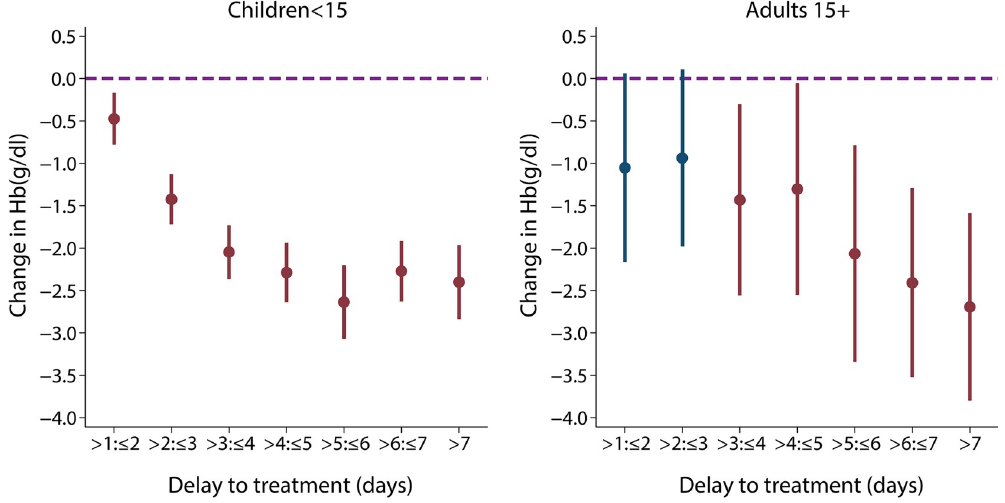
Fig 4. Treatment delay and change in Hb levels for (A) children aged under 15 and (B) adults aged 15 years and over. The change in Hb in g/dl for each extra day of delay compared with Hb in those treated within 24 hours. An increase in delay was associated with decrease in Hb levels (children: likelihood ratio χ 2 (7) = 361.16, p < 0.001; adults: likelihood ratio χ 2 (7) = 41.62, p < 0.001). Hb was recorded for 5,908 individuals in 10 of the studies, and its concentration was normally distributed. A mixed-effects general linear model was used to examine the relationship between delay and Hb levels, irrespective of severity group. On average, children who were admitted to the hospital more than 3 days after symptom onset had a reduction in Hb of at least 2 g/dl compared with those receiving treatment in the first day after illness onset. Hb,